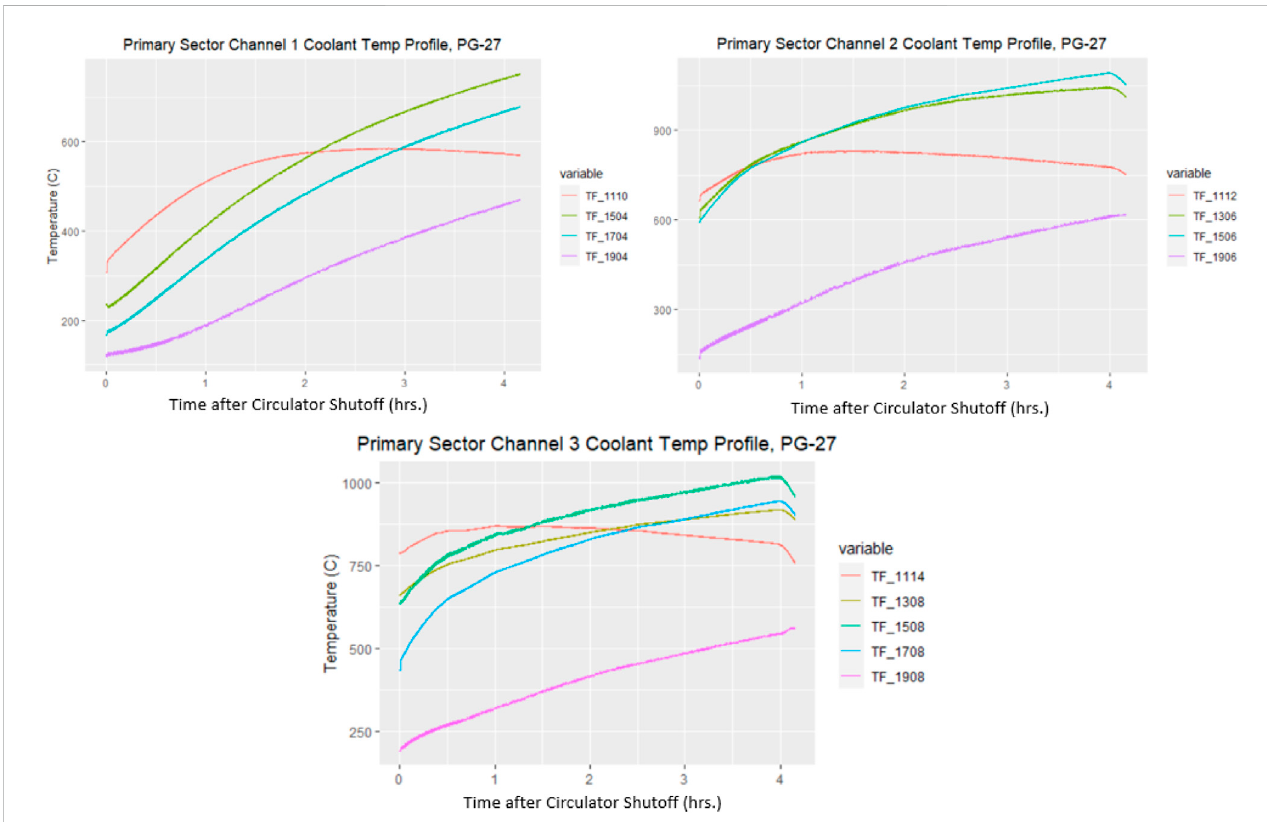
FIGURE 7 PG-27 Core primary sector, selected coolant channels temperature pro fi les (channels 1, 2, 3 representing inner, middle and outer core radial locations respectively).